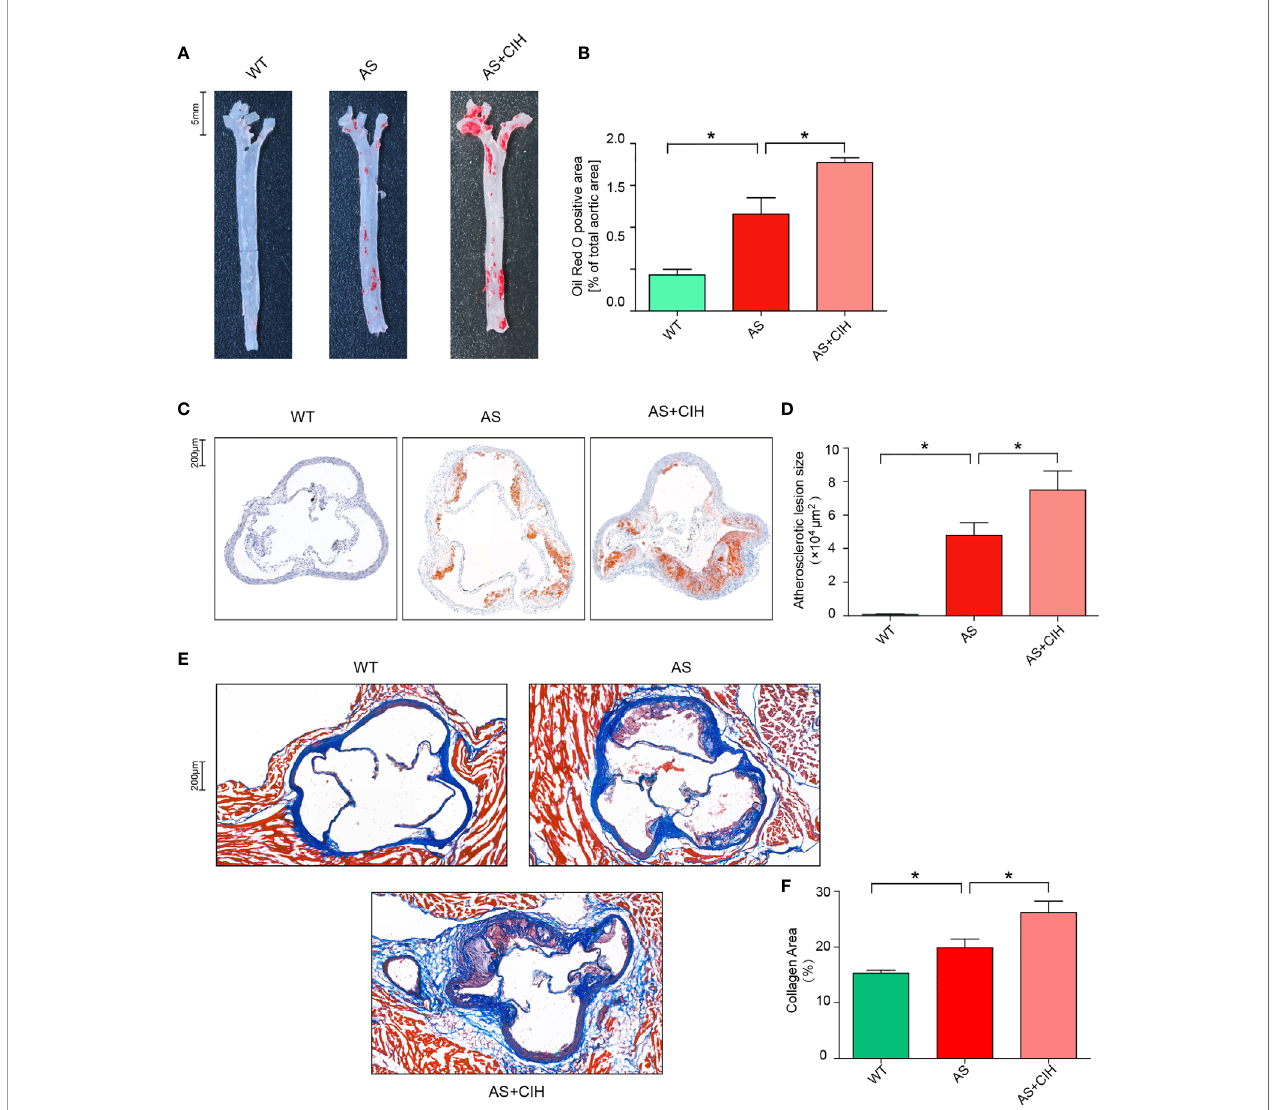
FIGURE 1 | CIH induces aggravation of atherosclerotic lesion burden in HFD-fed apoE -/- mice. (A, B) Representative photomicrographs of Oil Red O stainings and quantitative analysis of Oil Red O-positive area in the whole aortas. n=4 for WT, and n=5 for AS and n=4 for AS+CIH. Scale bar represents 5 mm. (C, D) Representative photomicrographs of Oil Red O stainings and quantitative analysis of atherosclerotic lesion area in the aortic sinus. n=4 for WT, and n=5 for AS and n=4 for AS+CIH. Scale bar represents 200 m m. (E – F) The degree of fi brosis in the aortic sinus was determined in masson-stained cross-sections. Representative sections and quantitative analyses of collagen area are shown. n=4 for WT, and n=5 for AS and n=5 for AS+CIH. Scale bar represents 200 m m. * P value < 0.05,